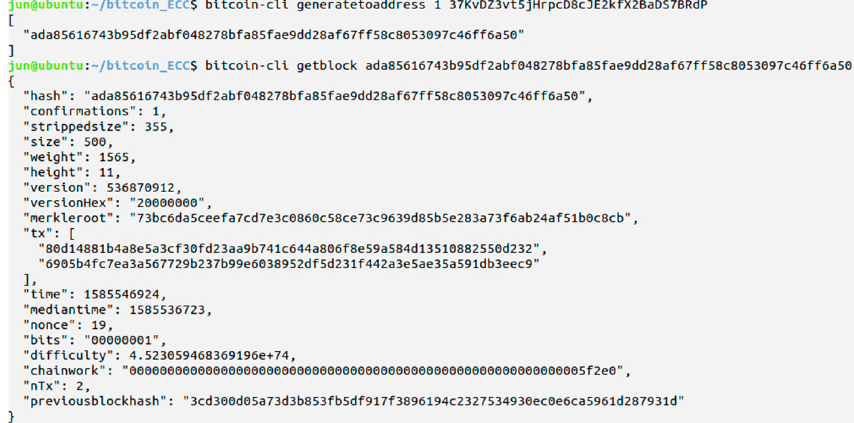
Figure 12. Insert transaction to block in bitcoin.